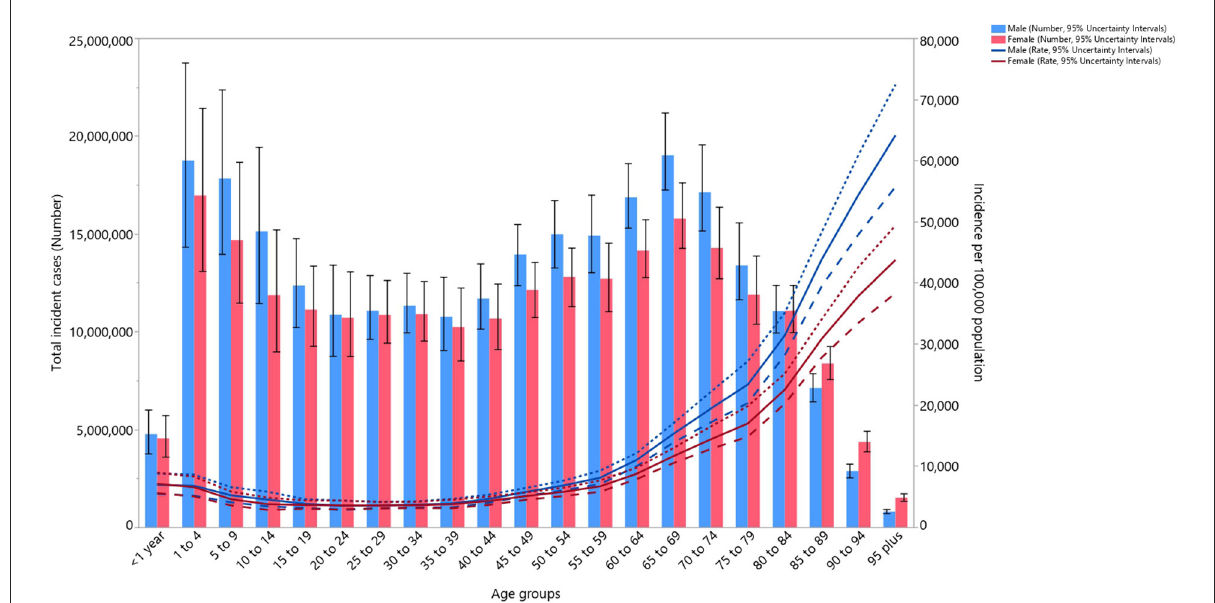
FIGURE3 Global number of incident cases and incidence rate of lower respiratory infections (per 100,000 population) by age and sex in 2019; Dotted and dashed lines indicate 95% upper and lower uncertainty intervals, respectively (generated from data available from http://ghdx.healthdata.org/ gbd-results-tool).